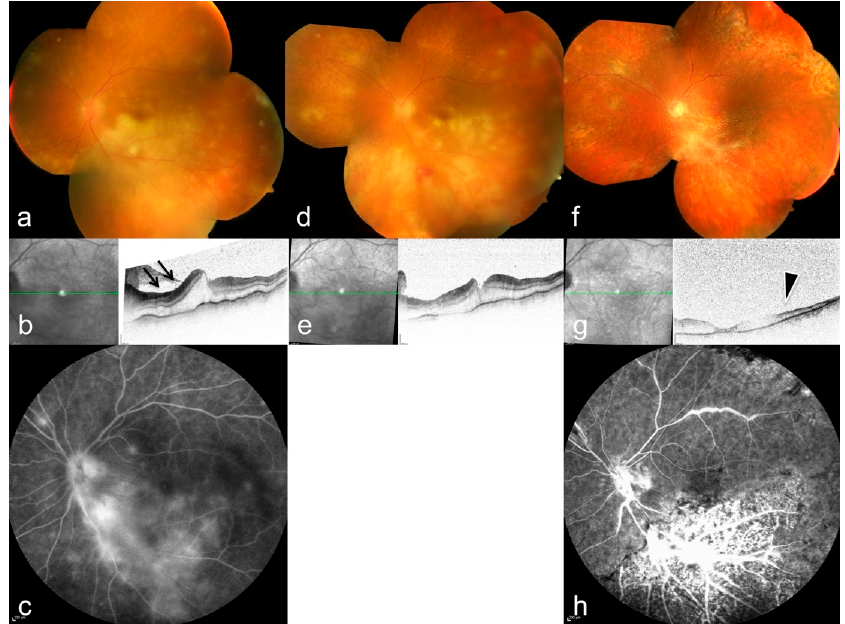
Figure 4. Corresponding left eye of the patient in Figure 3 on first presentation: ( a ) funduscopy with peripheral retinal infiltrations, ( b ) ischemic inner retinal layers (arrows), and edema in optical coherence tomography (OCT), ( c ) vascular leakage in fluorescein angiography (arrowheads). ( d – h ) follow-up with resolving infiltrates, development of bleedings ( d ), and retinal necrosis ( g , arrowhead). For further details see Table 1, patient 8.